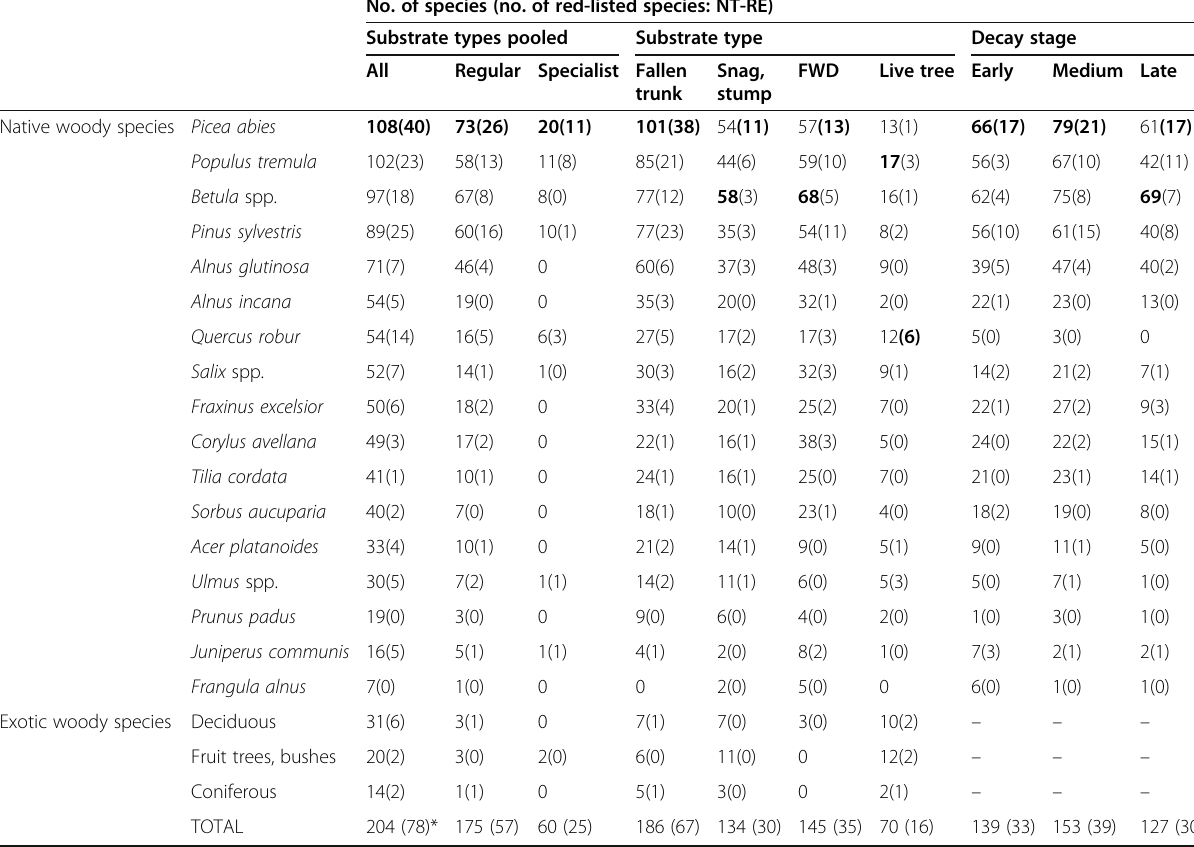
Table 4 Numbers of polypore species recorded on naturally developed woody substrates in Estonia. The most species rich substrate in each substrate category (column) is indicated with bold script. Species counts by substrate type and decay stage may not correspond to the pooled species count of a tree species since some records lacked detailed substrate data. See Methods for the criteria of ‘ regular ’ and ‘ specialist ’ species. ‘ - ‘ no information